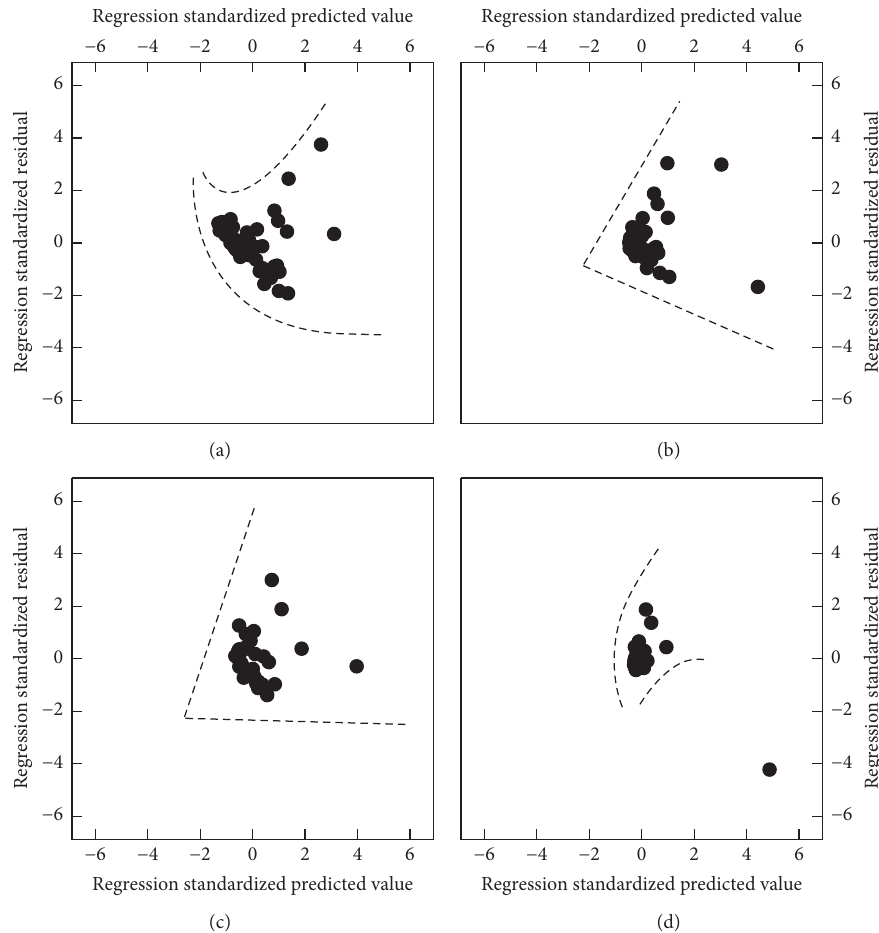
Figure 7: 8-day regression standardized residuals versus regression standardized predicted values of all models. (a) and (b) are linear and exponential models for MOD16A2, respectively, and (c) and (d) are linear and exponential models for SAFER algorithm,